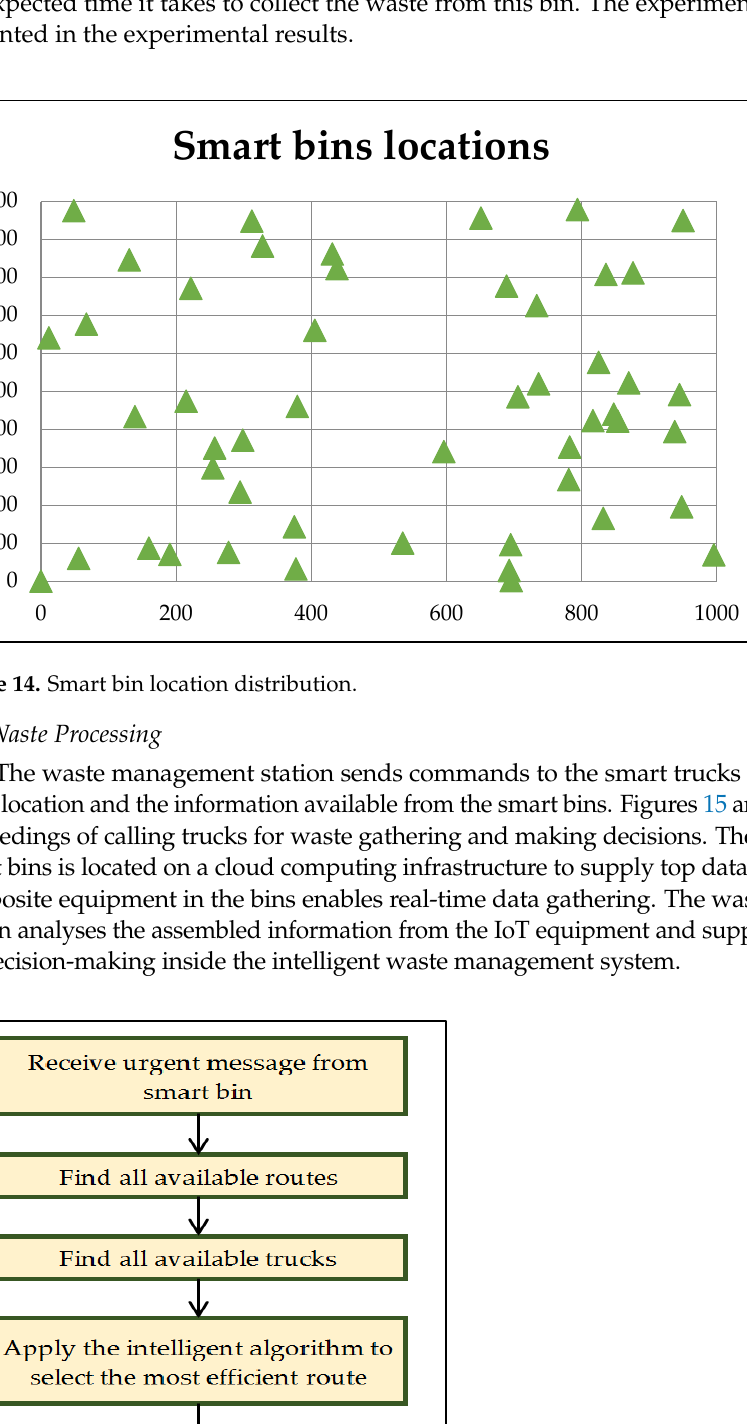
Figure 16. Procedures for decision-making in a smart bin. 4. Evaluation Results Evaluation is carried out through three scenarios. Each scenario uses a single truck applied for one waste type towards the 50 locations. The experiment is simulated and executed utilizing C++ and MATLAB by producing a random distribution for smart bins amongst 50 locations on 1000 m 2 as a part of the Khalidiyah zone and waste information, including smart bin status and waste type. The case values are randomly appointed for each smart bin to ensure conformance. Amongst all available routes to the smart bins, the most efficient routes are calculated on the grounds of the GA. Various routes are assessed to locate the most efficient route from the start point of smart trucks to the urgent smart bins that require cleaning. In this paper, assessment experiments are implemented for three smart trucks as- signed to collect the waste from the sorted urgent smart bin based on waste type and other smart bins considered ready for collection from the same waste type. All public areas and the other residents’ service locations are considered in this ex- periment, with no specific location to be cleaned more than any other. Unlike the existing system, priority is assigned depending on the smart bin waste status and waste source of